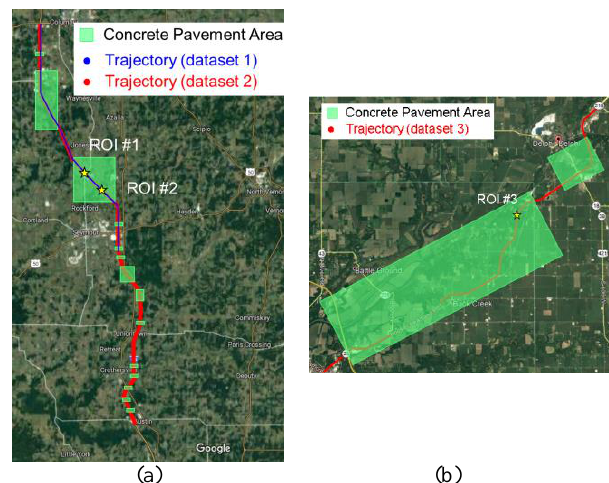
Figure 3. Trajectory, concrete pavement distribution, and regions of interest (ROIs) for generating intensity normalization maps of each LiDAR-based MMS dataset in (a) dataset 1 and 2, and (b) dataset 3